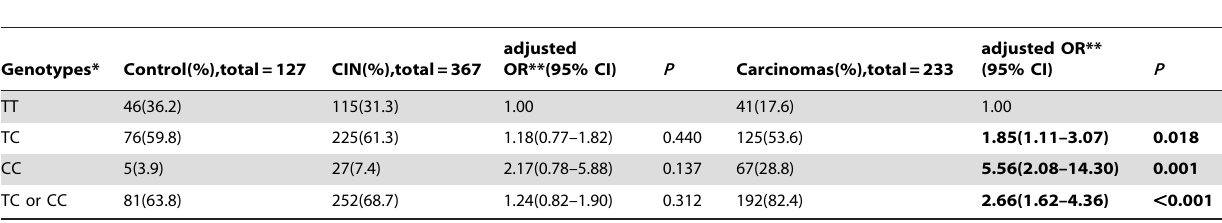
Table 3. According to HPV infection status(HPV positive) stratified analysis of the association between genotypes and risk of cervical carcinoma and CIN.